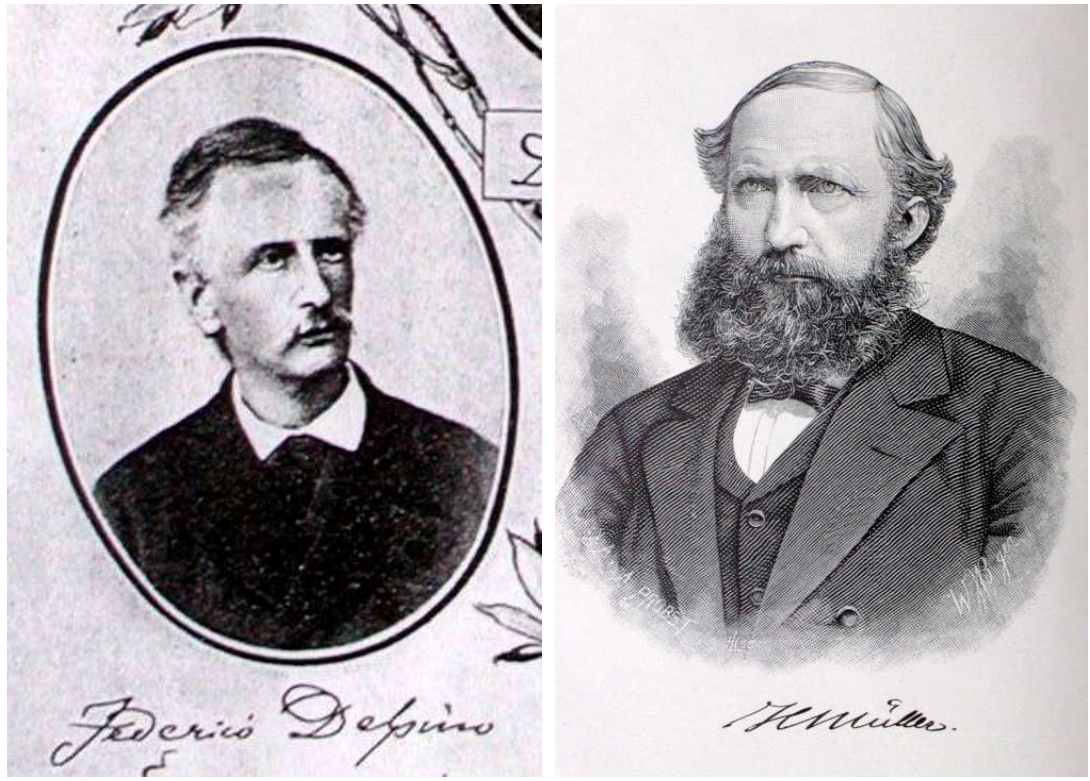
Fig. 1. Images of Federico Delpino (left), from the frontispiece of Knuth (1899), and of Hermann Müller (right), from the frontispiece of Knuth